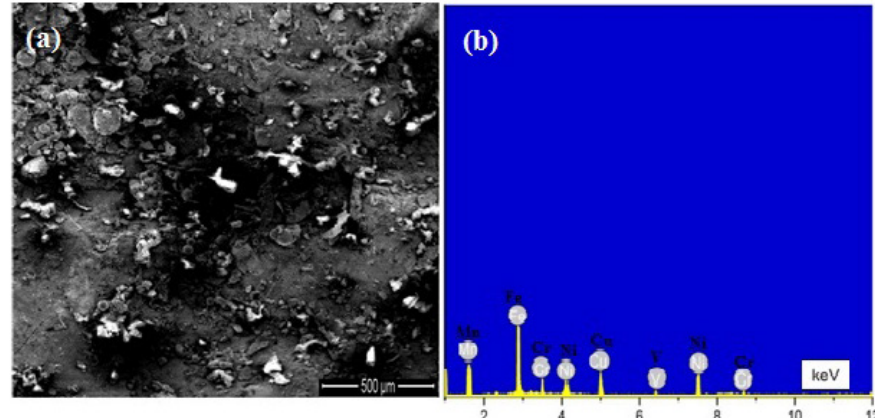
Figure 2. (a) SEM and (b) EDS result of the alloyed layer using Cu-10Ni- 6Cr at peak current of 9A, compaction pressure of 250Mpa and 6 wt.% Cr.